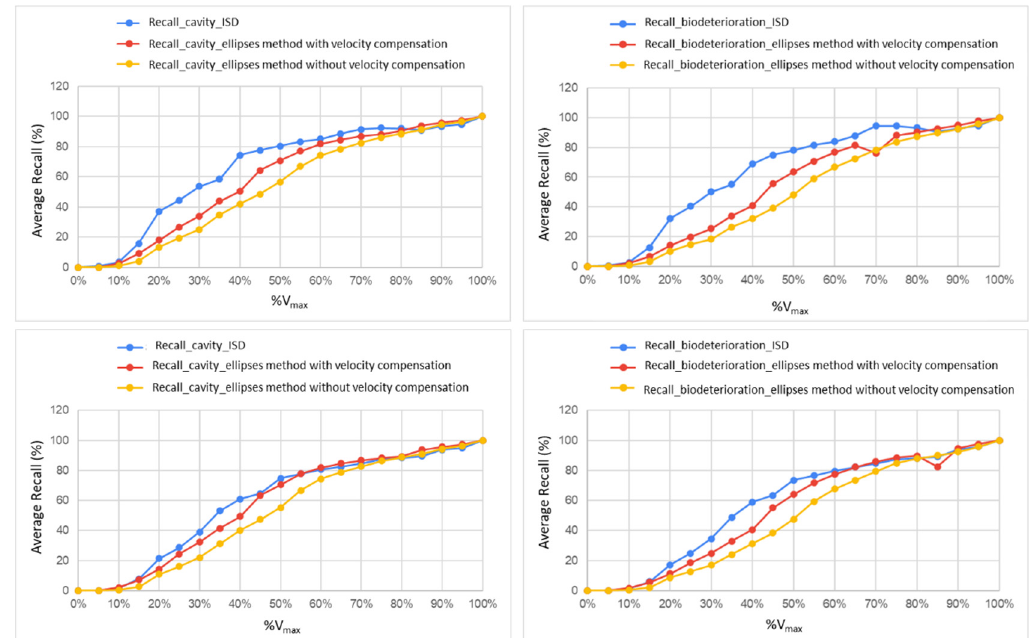
Figure 9. Behavior of the recall metric obtained with the application of the confusion matrix for the cavity and the cavity plus biodeterioration as zones of interest, without the application of filters (upper graphs) and with the application of filters (lower graphs).